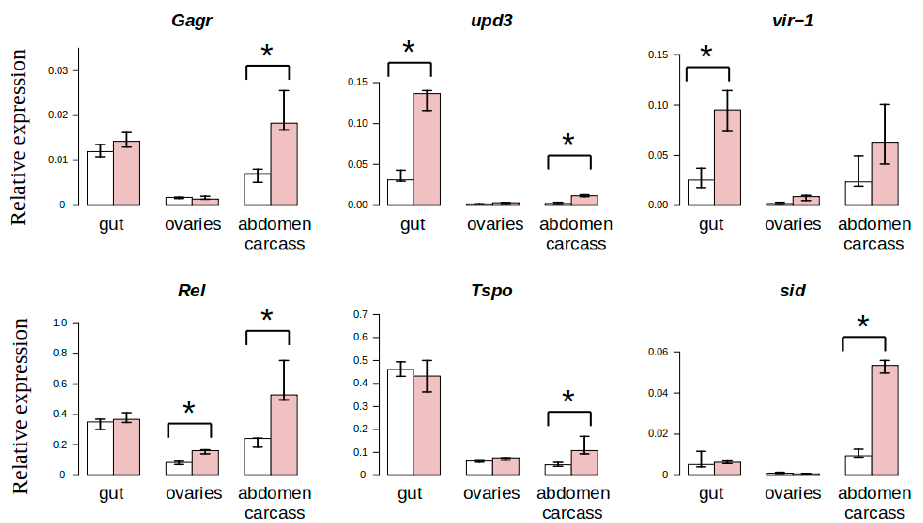
Figure 5. Tissue-specific activation of Gagr expression and stress-induced genes in D. melanogaster females in response to 24 h exposure to 0.1 M ammonium persulfate. White bars correspond to intact control; red bars correspond to the effects of ammonium persulfate. * - significant differences relative to control (Mann-Whitney test, p -value < 0.01, N = 5-6. The data are presented as median and interquartile range.